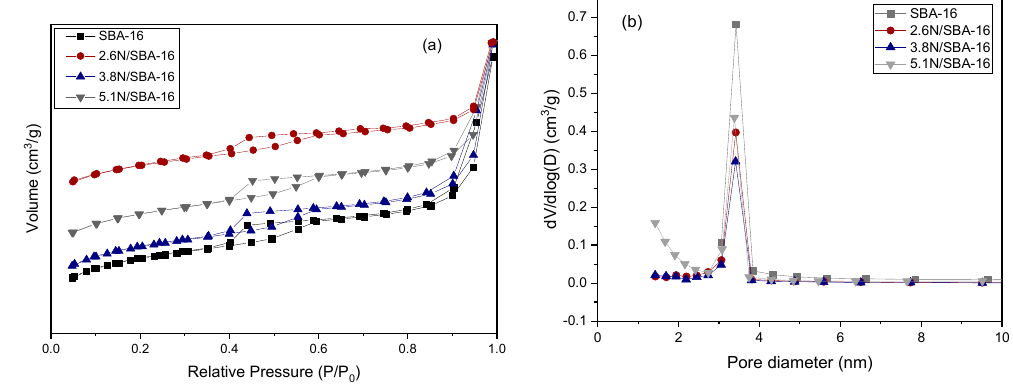
Figure 3. Non-functionalized SBA-16 solid and amino-functionalized adsorbents: ( a ) N 2 adsorption-desorption isotherms, and ( b ) Pore size distribution.